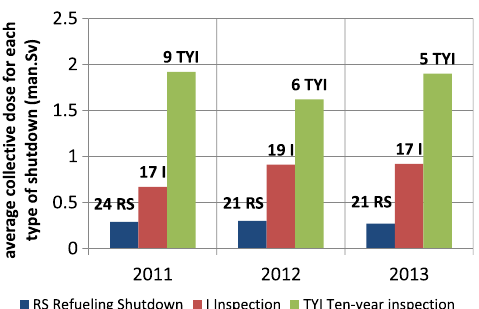
Fig. 3. Average collective doses for the French reactor fl eet by type of unit shutdown